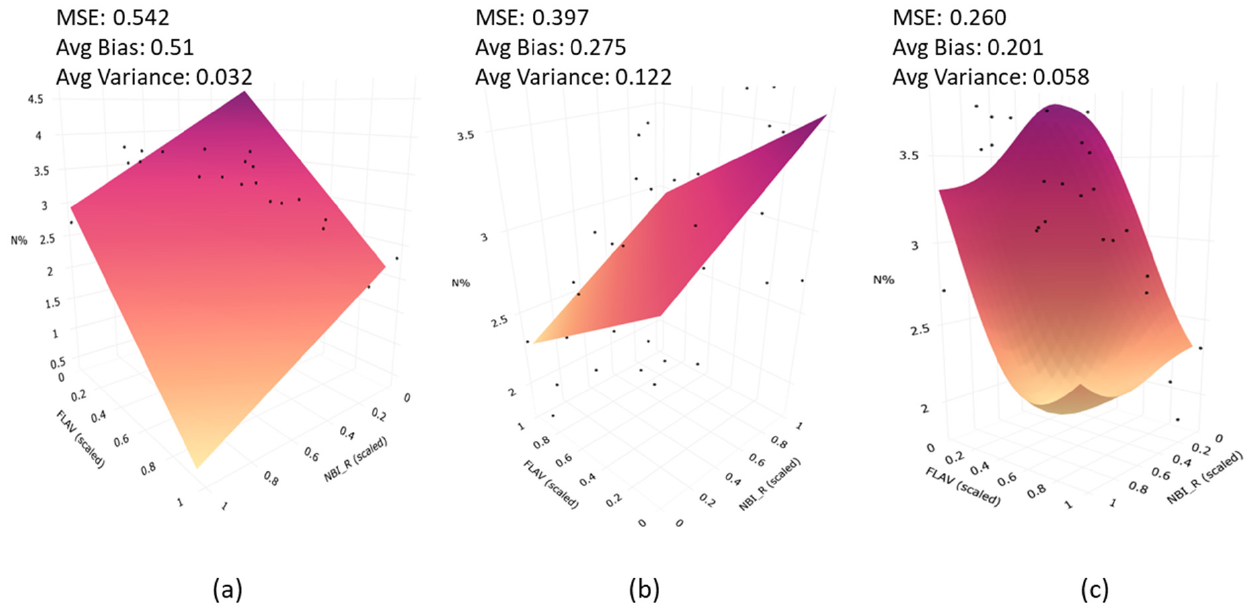
Figure 12. Prediction plane from ( a ) Multiple Linear Regression; ( b ) Partial Least Square Regression (PLSR); and ( c ) Support Vector Regression (SVR). The average Mean Squared Error (MSE), bias, and variances are highlighted for each model.